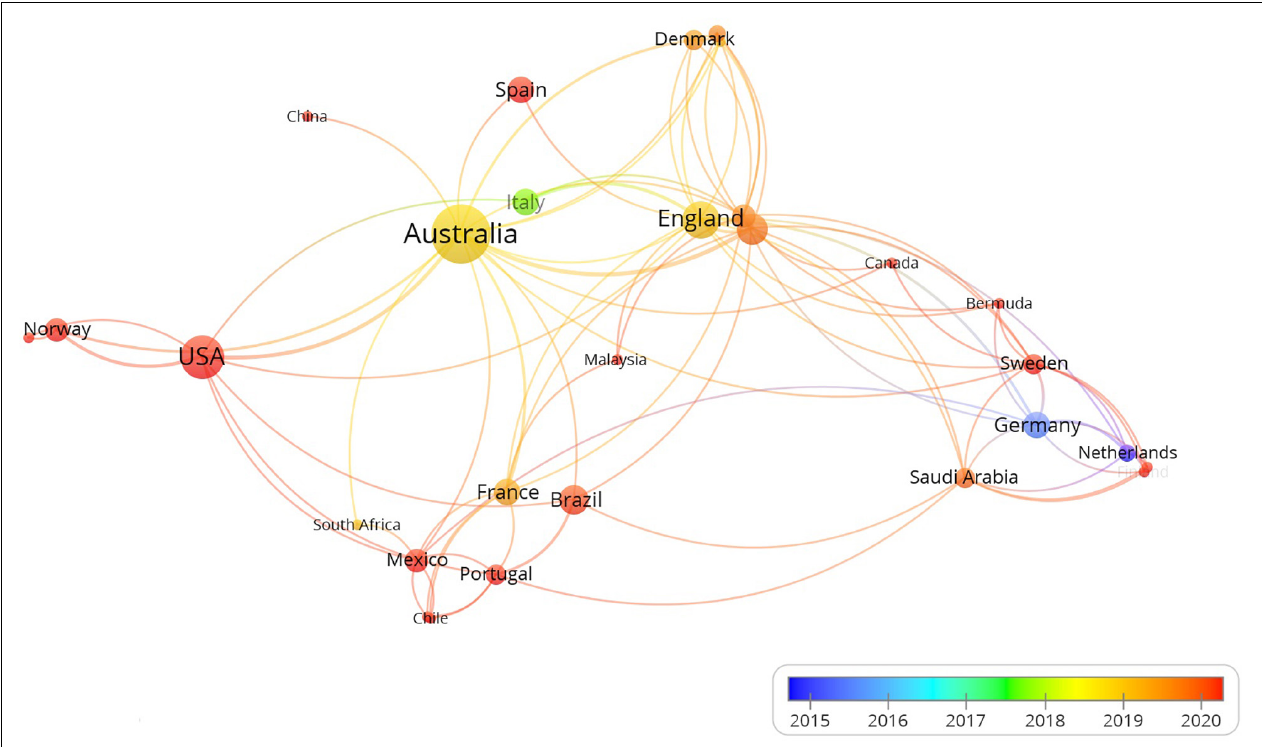
FIGURE 3 | Bibliometric map of the studies of the impacts of MHWs on algae based on co-authorship of countries (regions). The size of the dot is proportional to the frequency that a certain country (region) appears in the analyzed articles. The line between two dots means that these two countries (regions) appeared in the same article. The thicker the line, the more frequently the two countries (regions) appeared in the same articles. The color represents the year when a certain country (region) most frequently appeared in